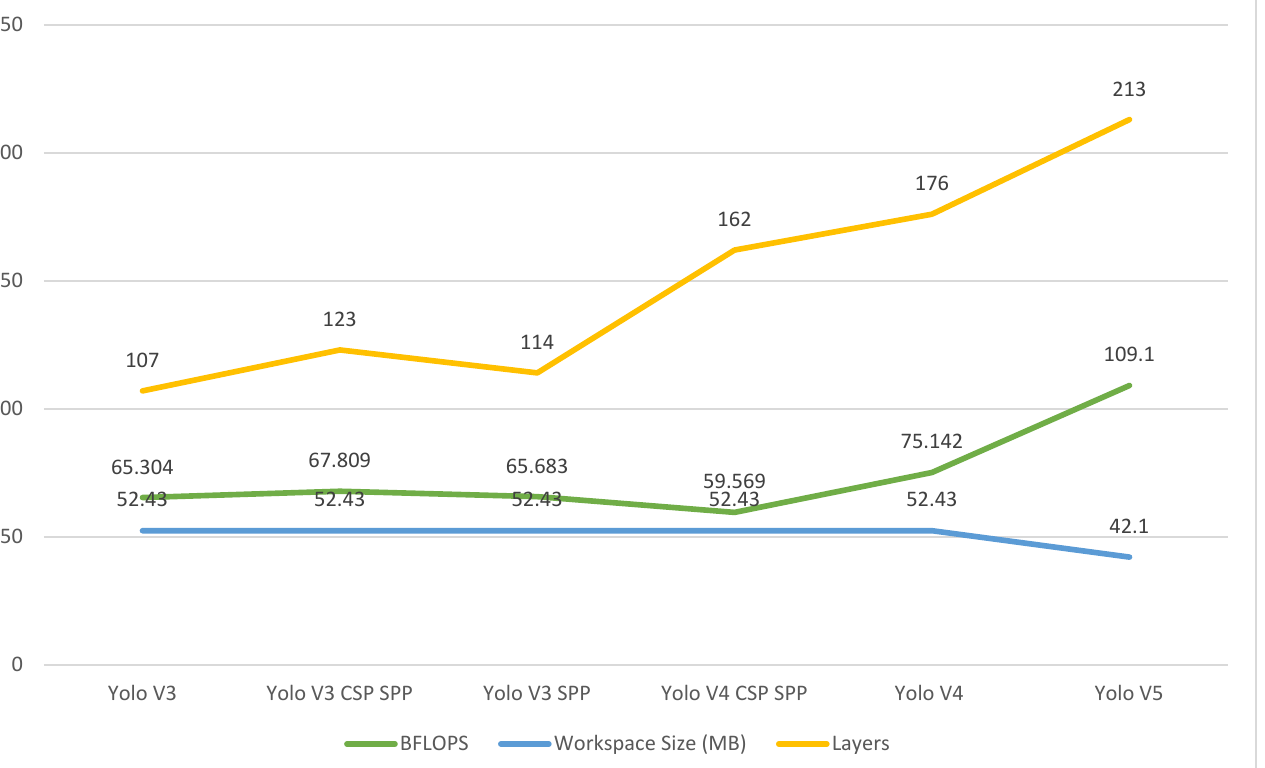
Figure 9. Comparison of BFLOPS, workspace size, and layers.